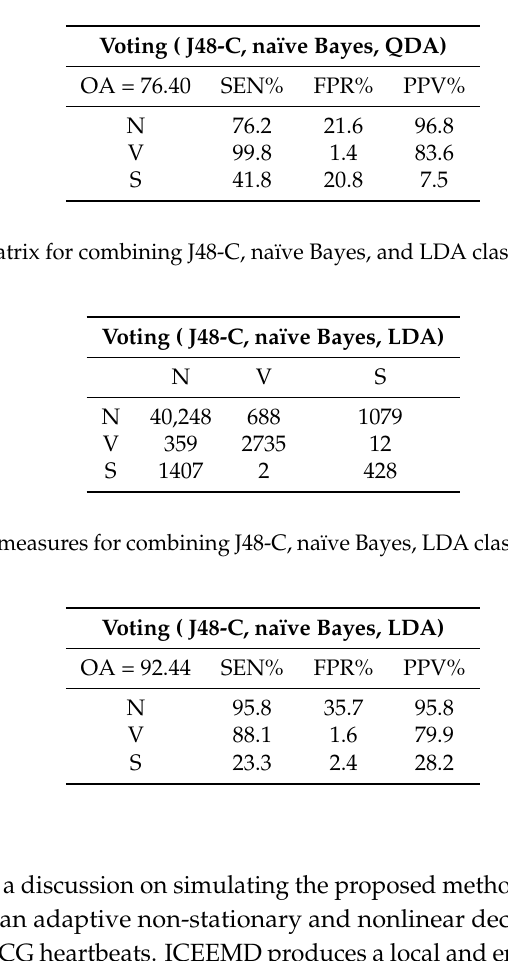
Table 23. Performance measures for combining J48-C, naïve Bayes, and QDA classifiers using Voting scheme (N,S,V).